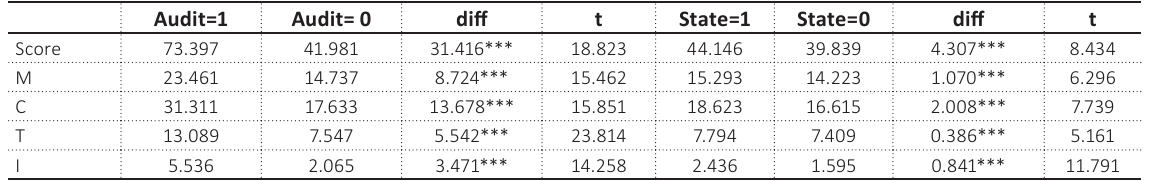
Table 4. Differences between companies on dummy variables: Audit and